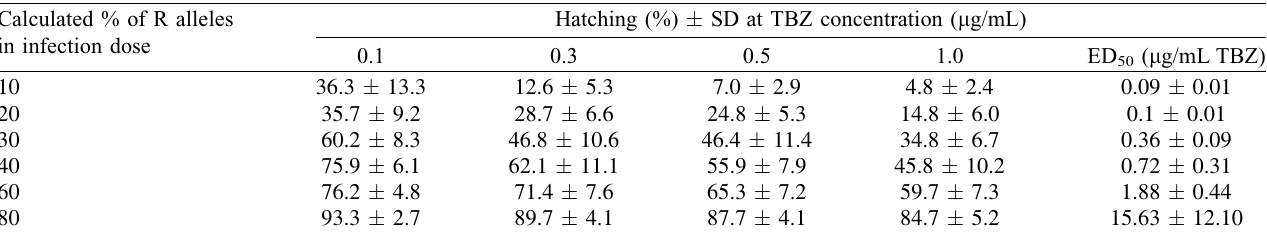
Table 2. Mean hatching (%) at different thiabendazole (TBZ) concentrations and ED 50 in the EHT in the groups of goats infected with different proportions of the resistant and susceptible isolates of Haemonchus contortus .